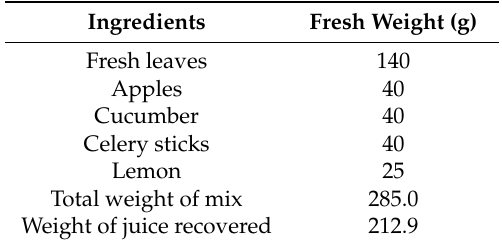
Table 2. Recipe of the fat hen juice mixture (g fresh